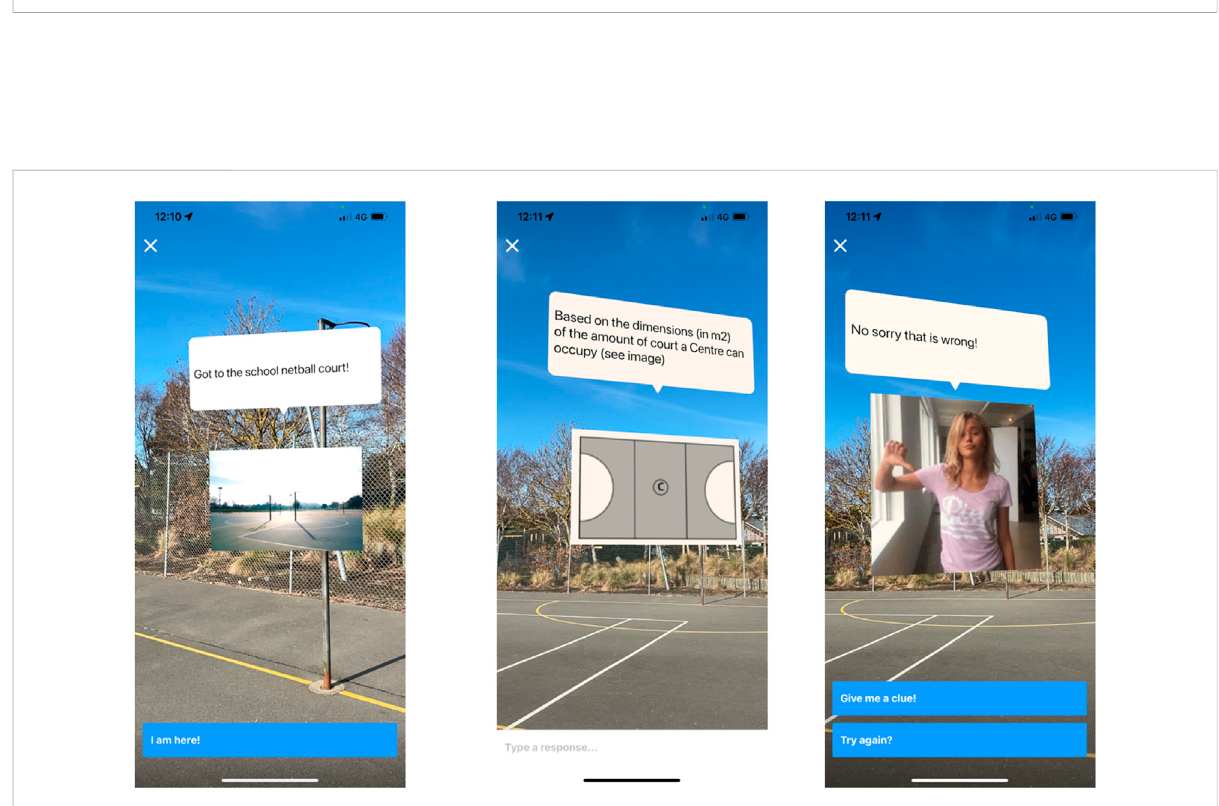
FIGURE 2 Sample question from the Maths Trail created in Metaverse. Students need to go the netball court and work out the area indicated in grey. Students needed to use their phones to measure the length of the court and then calculate the area.